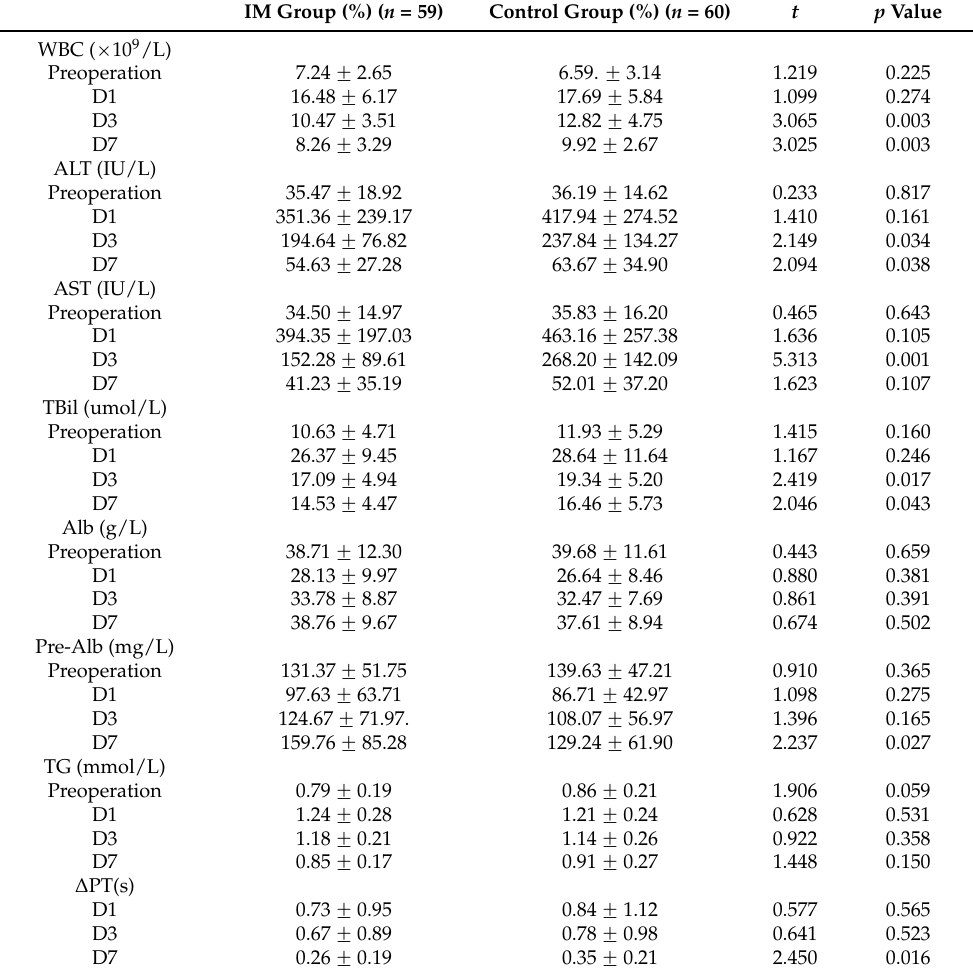
Table 2. Blood sample tests of the two groups before and after